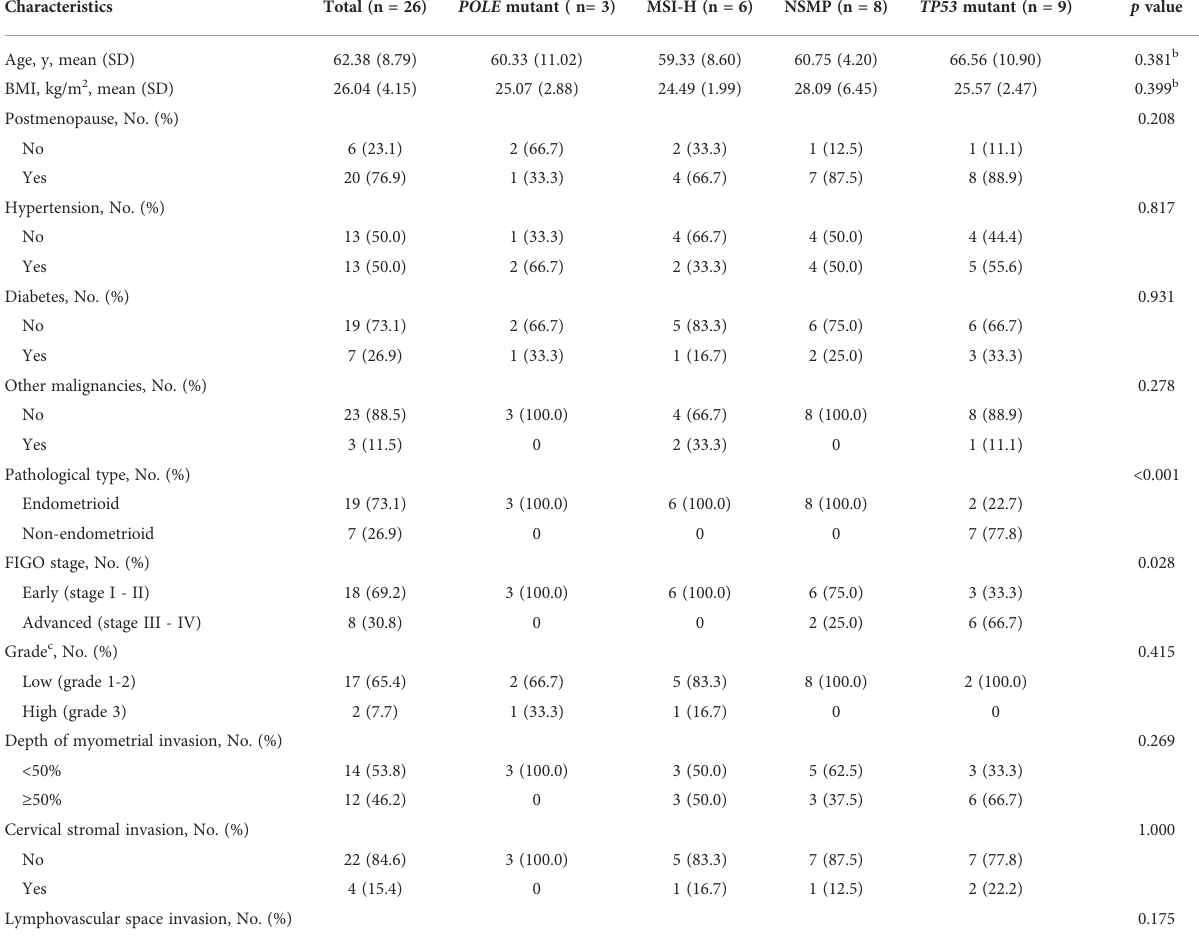
TABLE 1 Clinicopathological characteristics of primary EC cases a